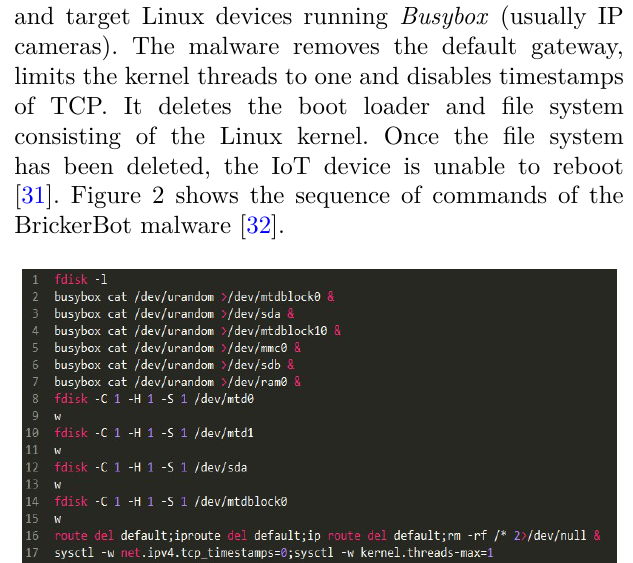
Figure 2. Mirai Setup